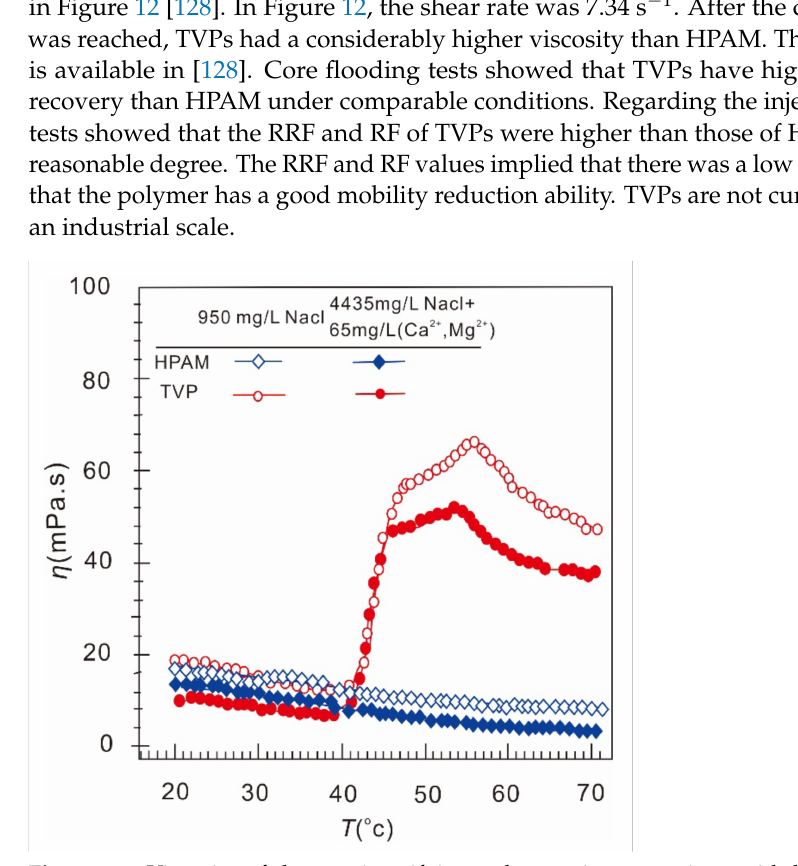
Figure 12. Viscosity of thermoviscosifying polymers in comparison with hydrolyzed polyacry- lamide